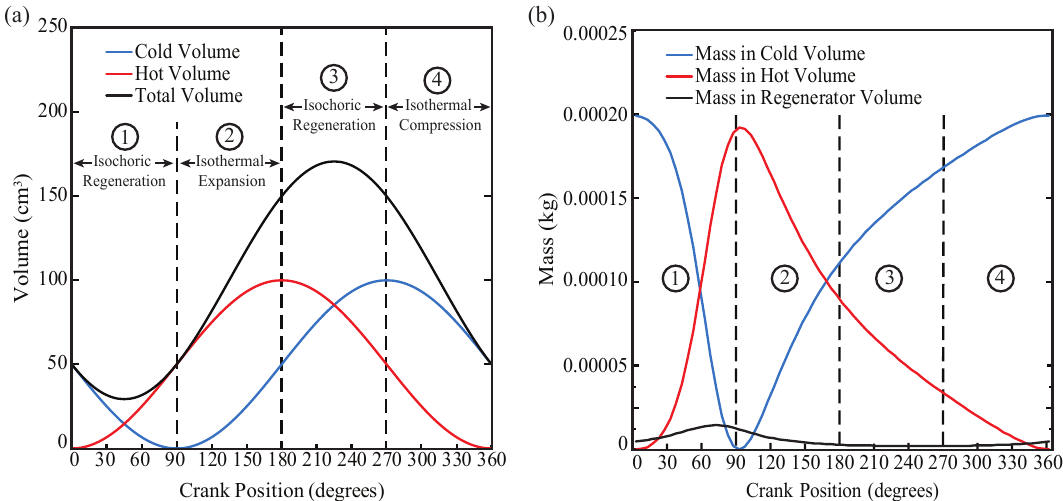
Figure 3. ( a ) Volume and ( b ) mass of the sinusoidal cycle as a function of crank angle ( θ ), for the alpha-type Stirling